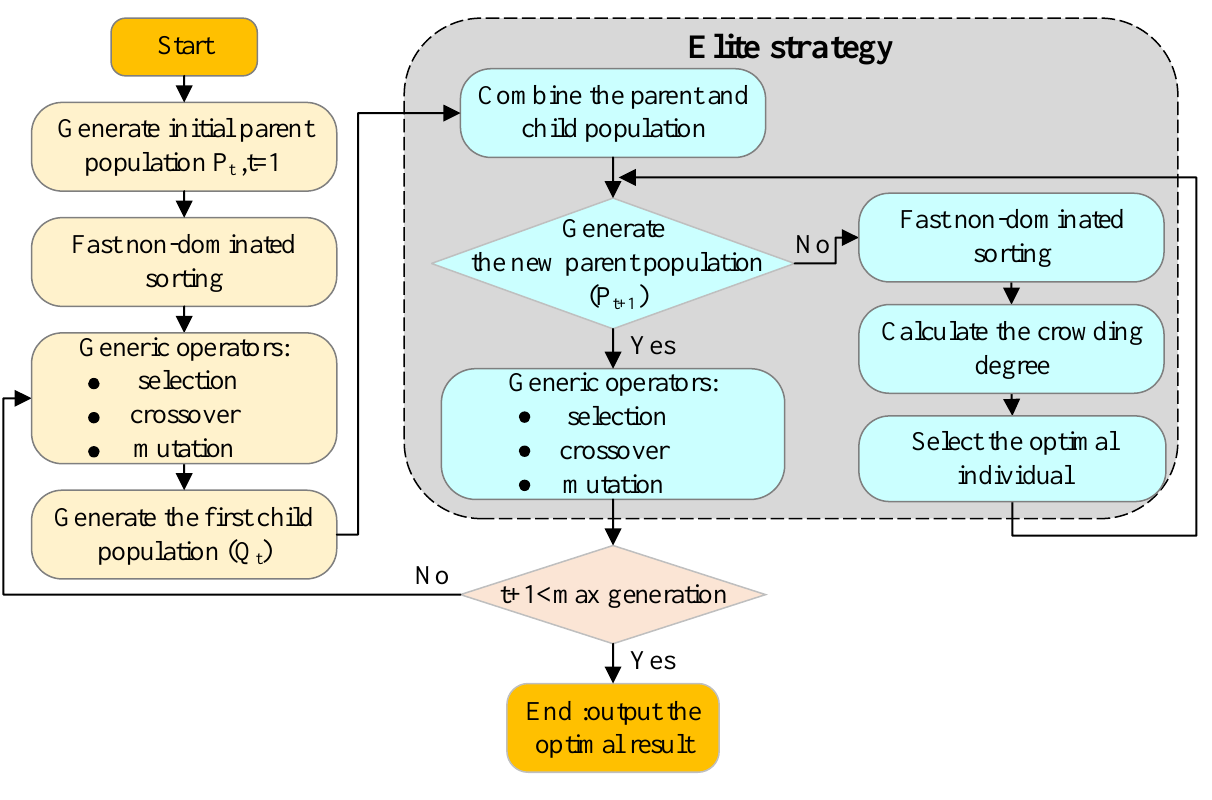
Figure 8. Diagram of NSGA-II.